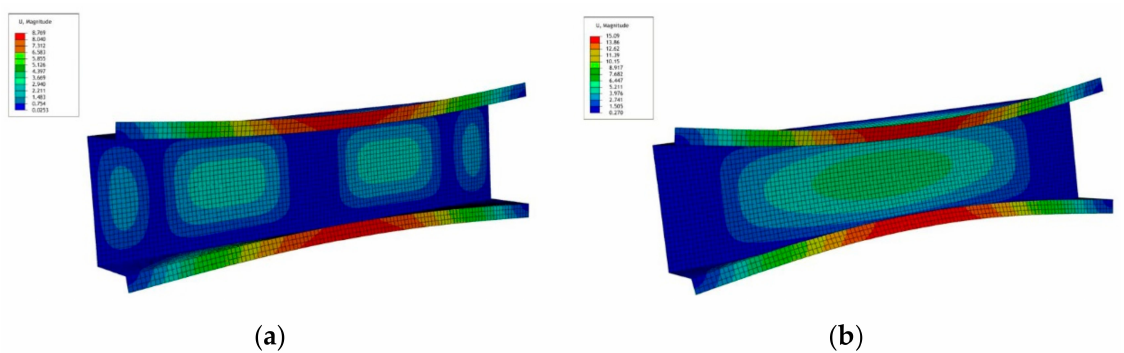
Figure 21. Collapse mode for the TH-channel of total length 330 mm at the moment the ultimate load-carrying capacity σ σ S / 7 = 2.04 is attained ( a ), and after a jump when